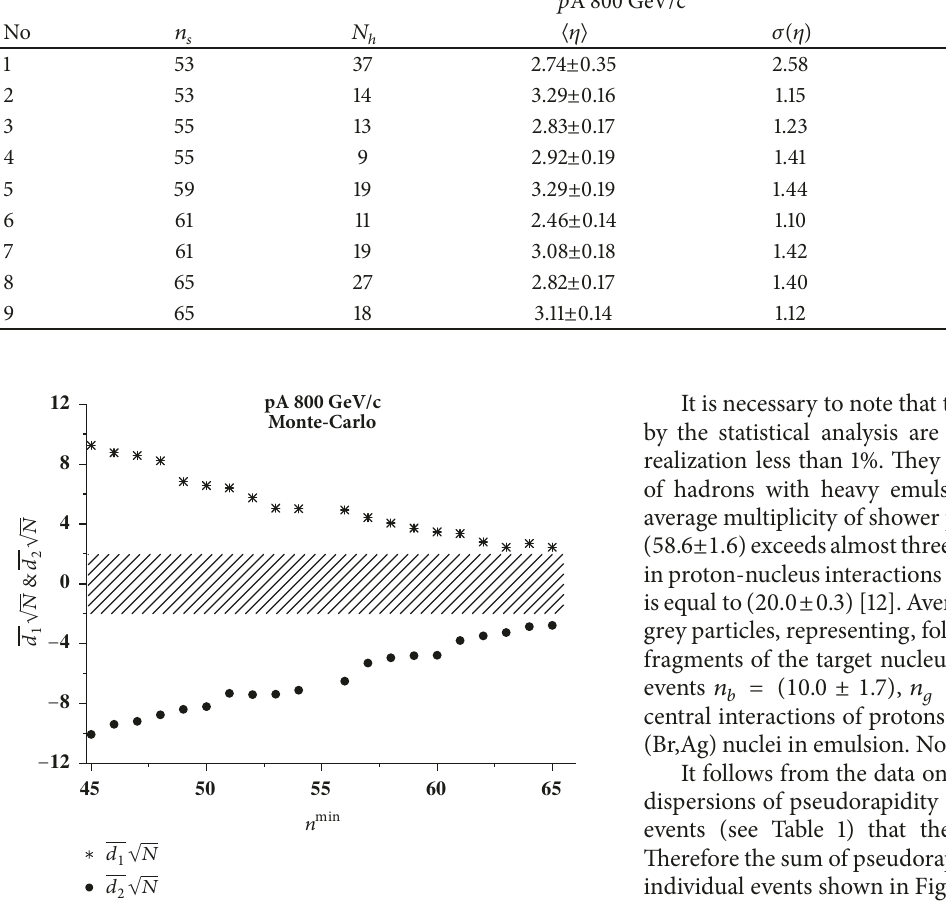
Figure 3: Dependence of parameters 𝑑 1 √𝑁 and 𝑑 2 √𝑁 on 𝑛 𝑚𝑖𝑛 for 5000 Monte Carlo generated events. The shaded area is the area where |𝑑 1 √𝑁| & |𝑑 2 √𝑁| < 2